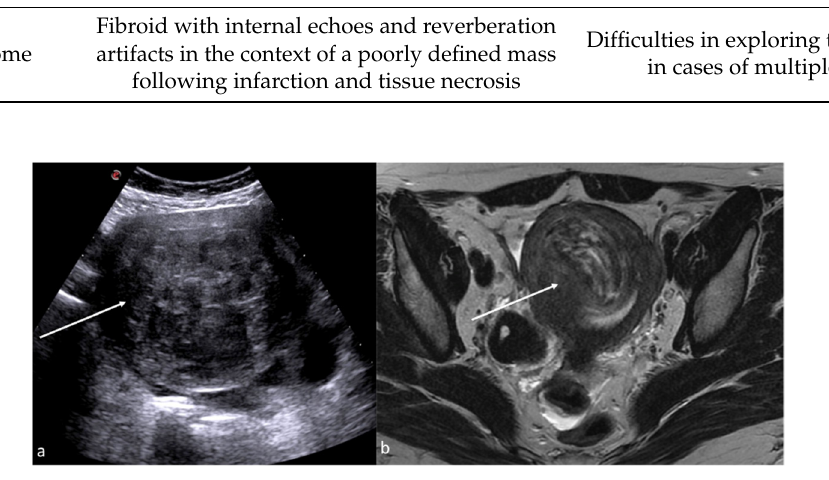
Figure 14. Post-embolization fibroid necrosis. Axial TSA-US ( a ) scan shows a heterogeneous